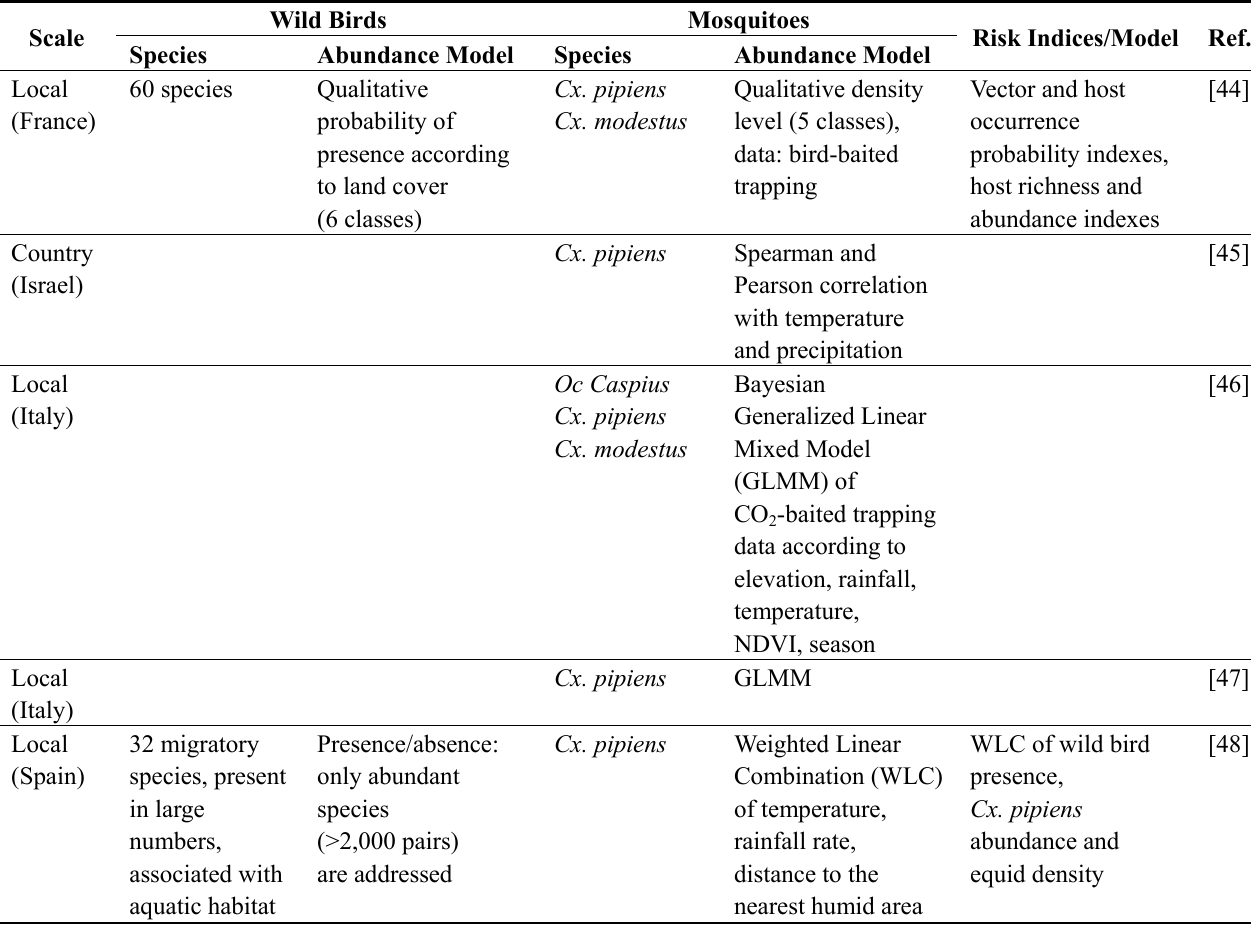
Table 2. List of articles aiming at producing risk maps for the transmission of WNV or WNF disease. Ref. stands for References.